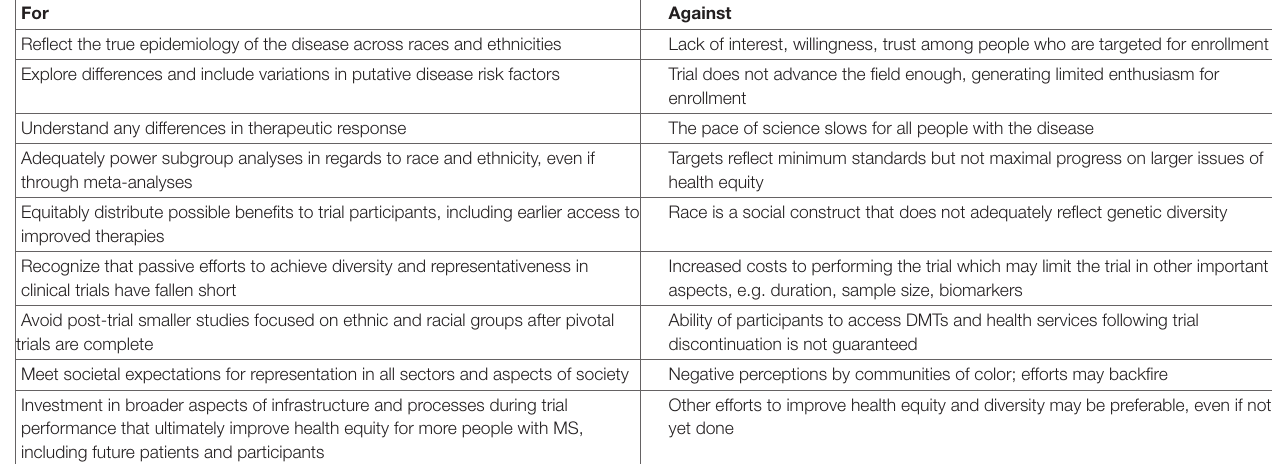
TABLE 1 | Summary of arguments For and Against enrollment targets (quotas) to improve racial and ethnic diversity in MS late-phase therapeutic clinical trials. For